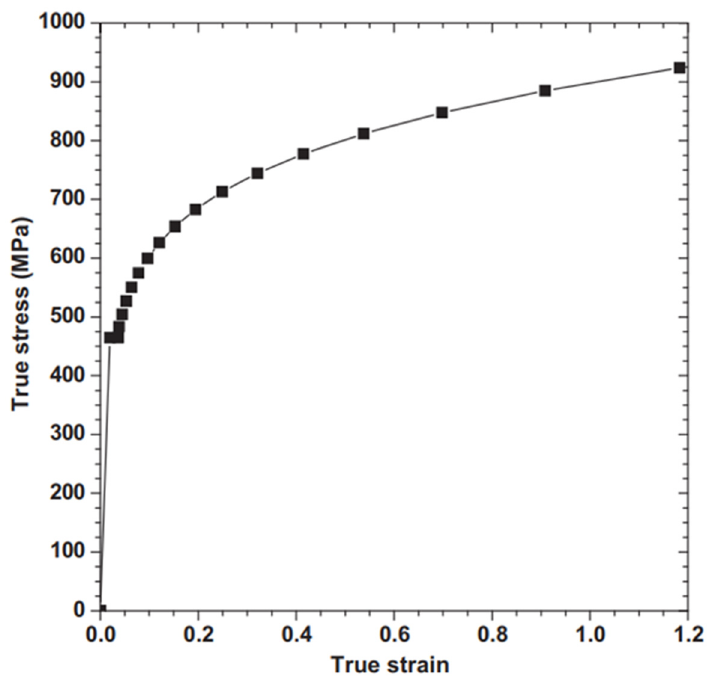
Figure 3. Pipe model meshed with elements.